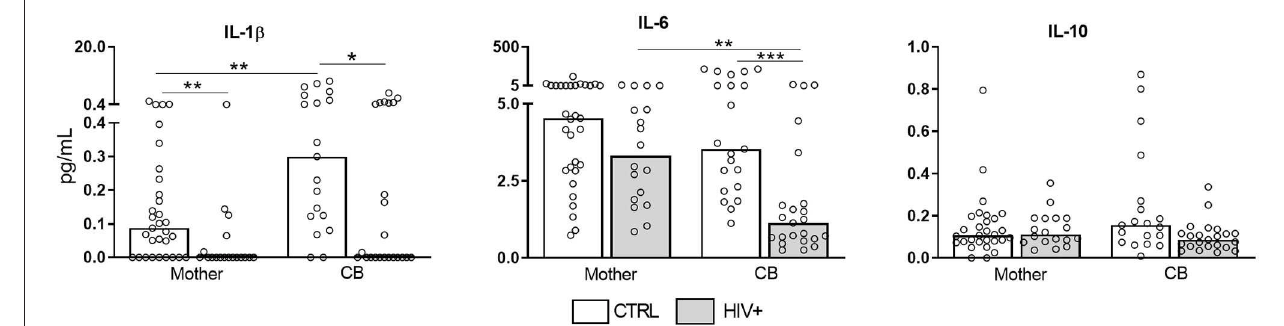
FIGURE 3 | Decreased serum levels of pro-inflammatory cytokines in HIV-infected mothers and exposed newborns. Serum samples from HIV-infected mothers and cord blood (CB) (gray bar, n = 18–23) and control uninfected mothers and CB (white bar, n = 18–29) was assessed for presence of IL-1 β , IL-6, and IL-10 by cytometric bead array. Data represent median values. The detection limits were: IL-10 = 13.7 fg/mL; IL-6 = 68.4 fg/mL; IL-1 β = 48.4 fg/mL. Mann-Whitney U or Wilcoxon signed-rank test: * p < 0.05, ** p < 0.01, *** p < 0.001.